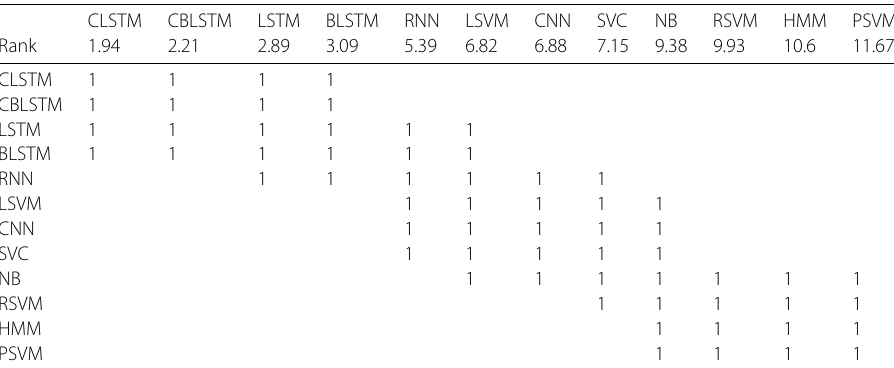
Table 9 Results of the Friedman and the Nemenyi post-hoc tests. The rank row shows the rank of the models according to the Friedman test (lowest is best). A table entry 1 indicates that the model in the column is in the same group with the model in the row and vice versa, i.e, they are not significantly different according to the Nemenyi post-hoc